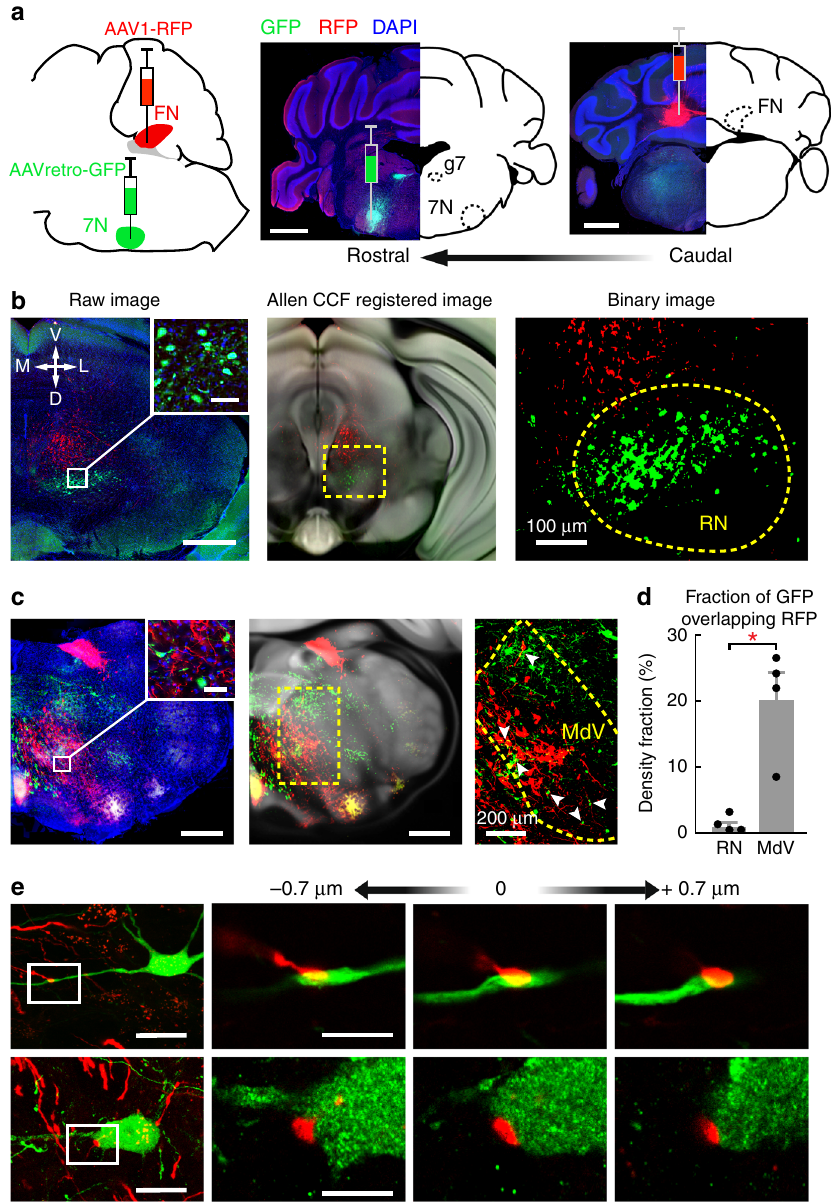
Fig. 8 Anatomical tracing reveals a FN-MdV pathway for DEC. a Sketch of the viral tracing strategy (left). Middle and right images: coronal sections of the injection sites from an example animal. Retrograde GFP and anterograde RFP were simultaneously injected into the ipsilateral facial nucleus (7N, middle) and FN (right). Labeled fi bers in the genu of facial nucleus (g7) con fi rm the targeting of the 7N. Scale bars, 1 mm. b Representative images of retrogradely labeled neurons (green) and anterogradely labeled FN axons (red) at the level of caudal midbrain. The raw image (left) is registered to the Allen Mouse Brain CCF (middle, see “ Methods ” ) for further quanti fi cation of the FN projection in the contralateral red nucleus (right image, the RN is denoted by a dashed-line contour). Scale bars, 500 µ m, inserted image 50 µ m. c Same as ( b ), but for labeling in caudal medullary regions. Colocalizations of 7N projecting neurons and FN axons are found in the contralateral ventral medullary reticular nucleus (MdV, arrowheads in the right image). Scale bars, 500 µ m, inserted image 50 µ m. d Comparison of colocalizations in the RN and MdV from 4 mice (mean ± s.e.m., paired two-sided t test, * P = 0.020). e Confocal images of two example MdV neurons with FN axons targeting their primary dendrite (top) and soma (bottom). Scale bars, left column, 20 µ m, right columns,10 µ m. Tracing experiments were performed and replicated in n = 4